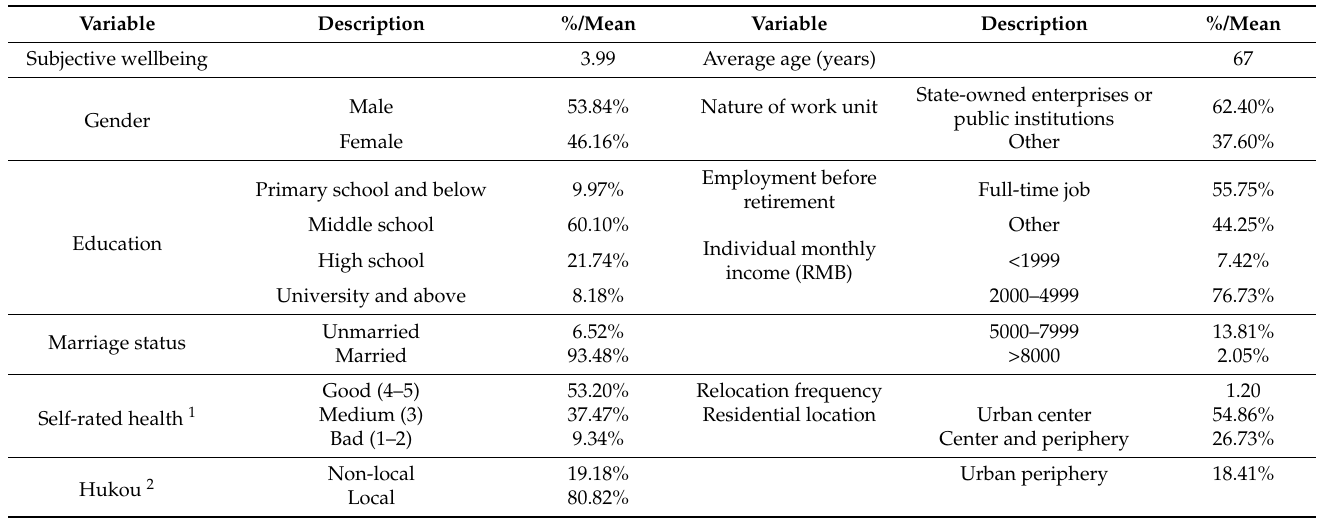
Table 1. Sociodemographic attributes of the survey participants ( N =